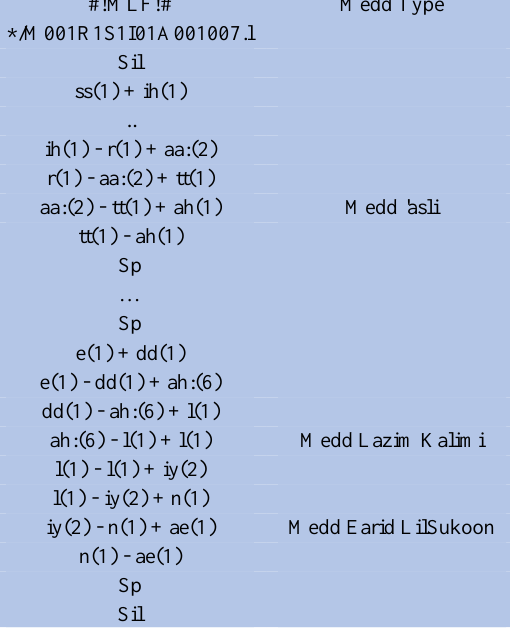
Figure 14. Sample of triphone of